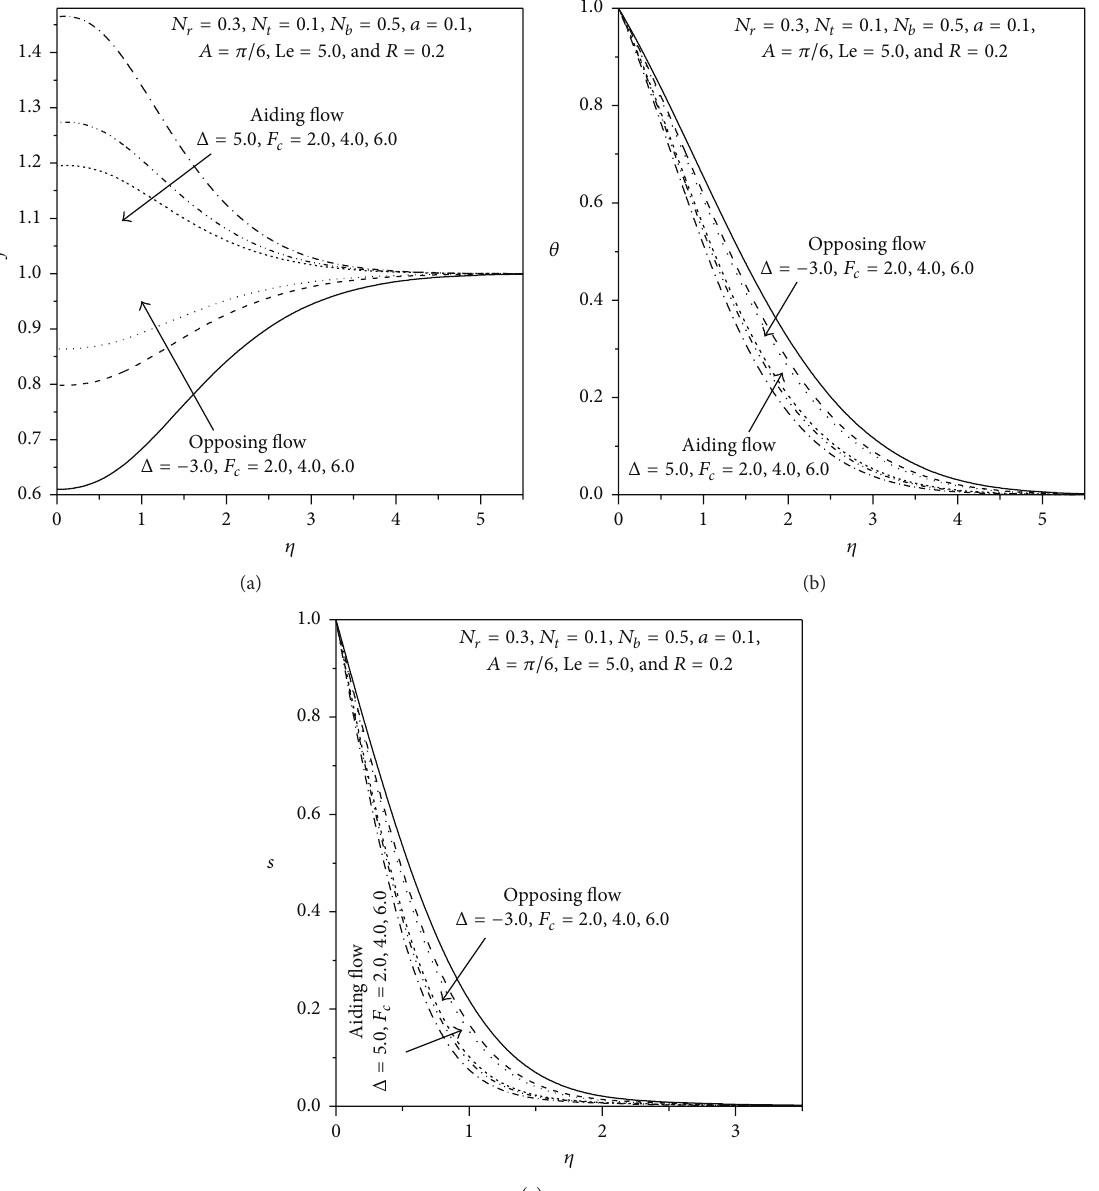
Figure 4: Variation of (a) velocity, (b) temperature, and (c) nanoparticle volume fraction profiles with non-Darcy parameter ( 𝐹 𝑐 ).